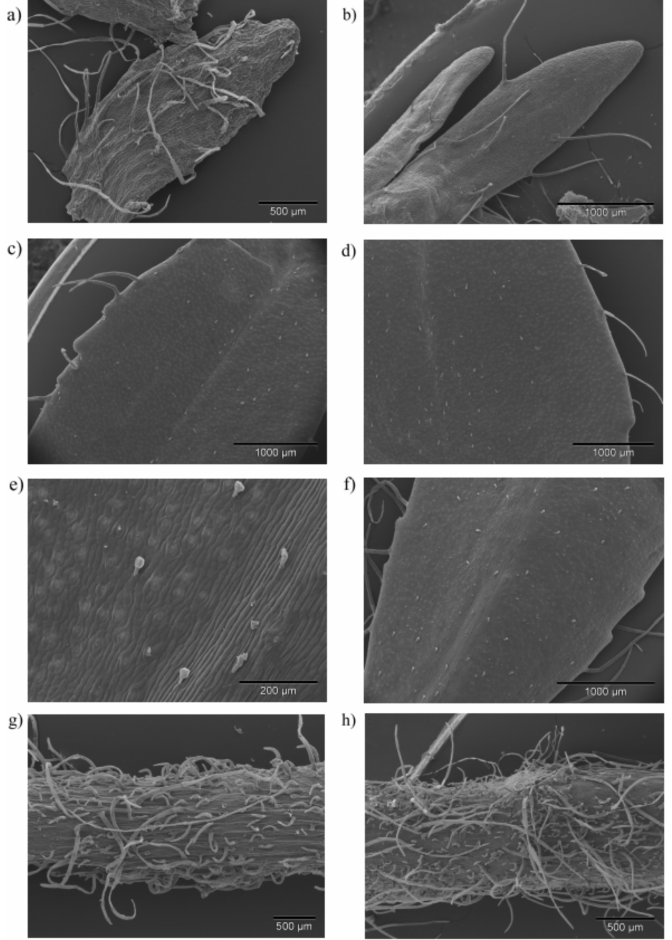
Figure 2. SEM micrographs of the di ff erent trichome types of V. saturejoides ssp. saturejoides . Rare ( a , b ) and dense ( g , h ) indumentum of non-glandular trichomes on the calyx ( a , b ) and stem ( g , h ); glandular trichomes on the adaxial ( c , d ) and abaxial ( e , f ) leaf surface; micrographs of Prenj ( a , c , e , f , g ) and Kamešnica ( b , d , h ) sample. Table 2. Occurrence and frequency of trichomes on aerial parts of Veronica saturejoides ssp. saturejoides .